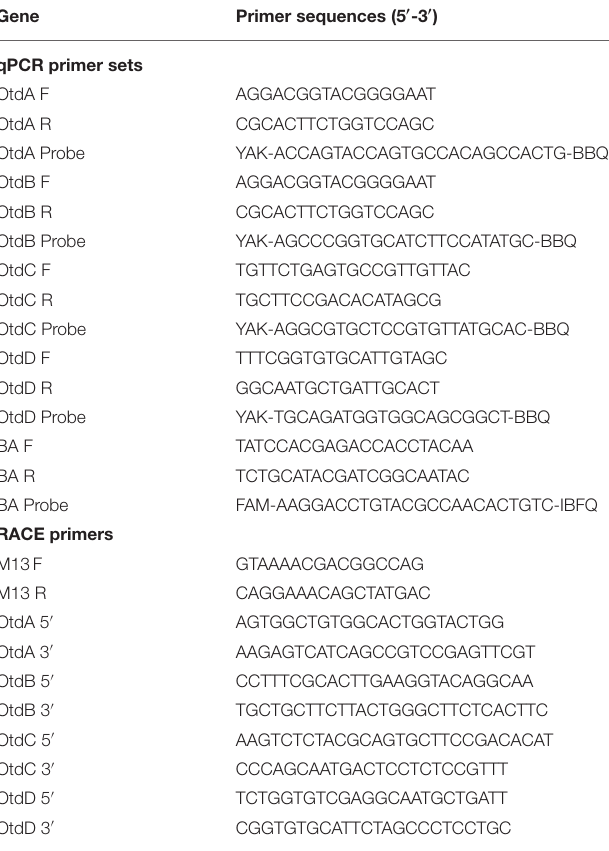
TABLE 1 | Oligonucleotides and probes used for qPCR and RACE. Gene Primer sequences (5 ′ -3 ′ ) qPCR primer